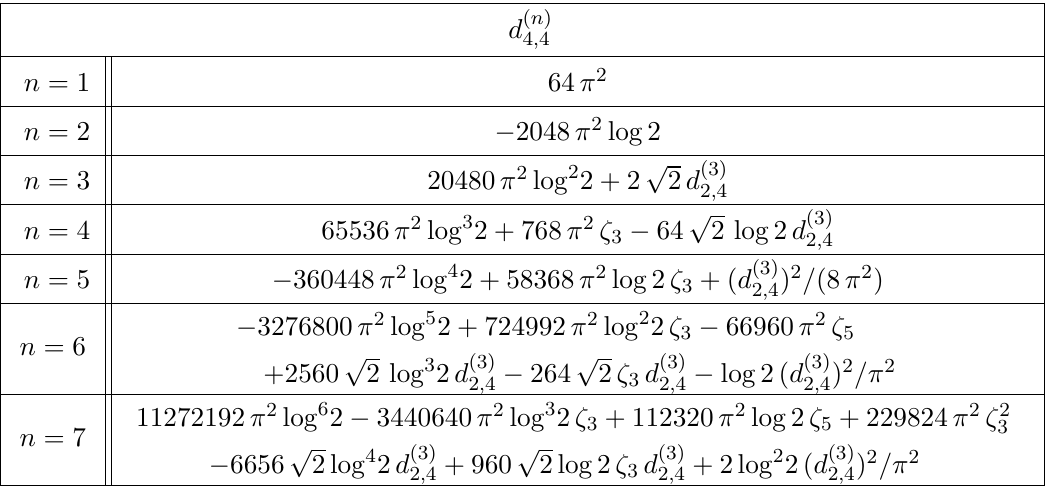
Table 2 . The first seven coefficients d ( n )